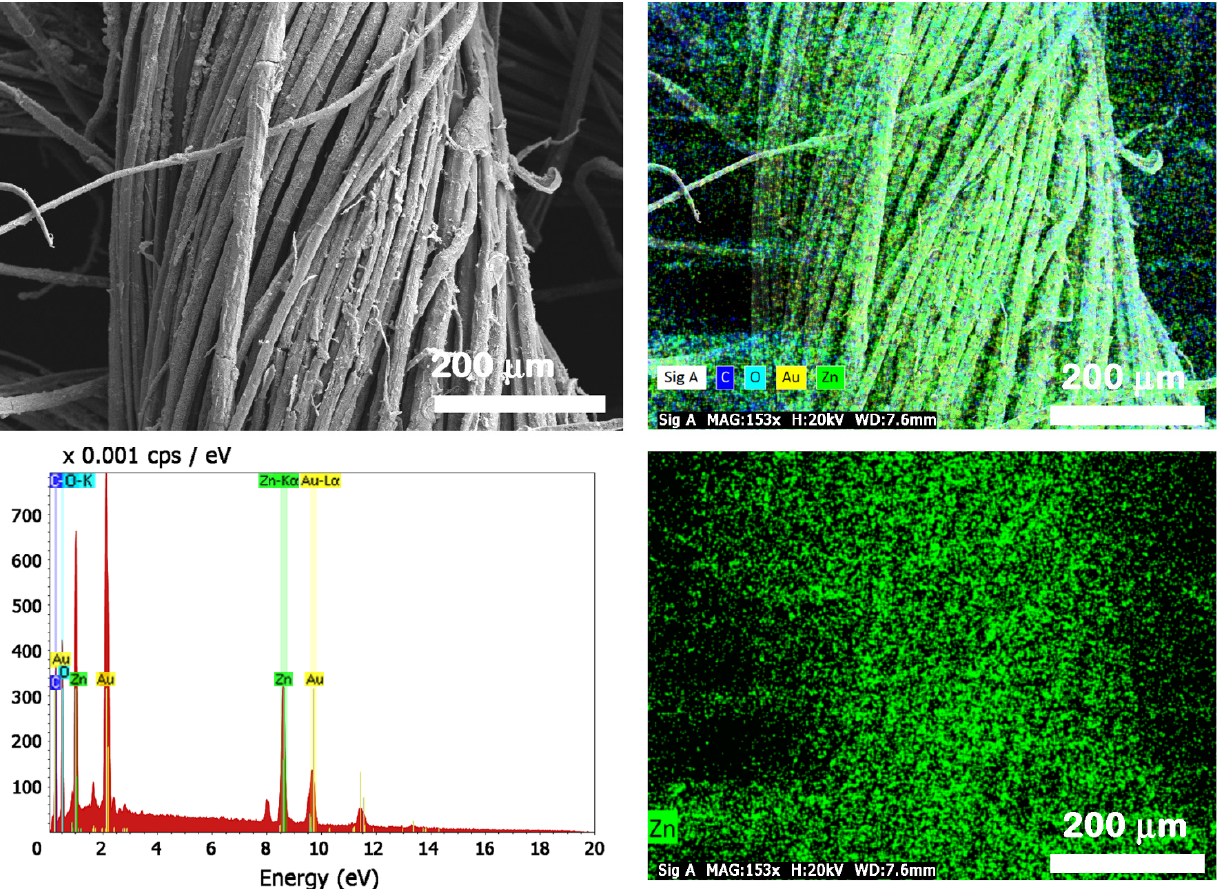
Figure 6. FESEM image, EDX mapping and EDX spectrum of ZnO-coated flax fabrics and the EDX mapping only for Zn element.